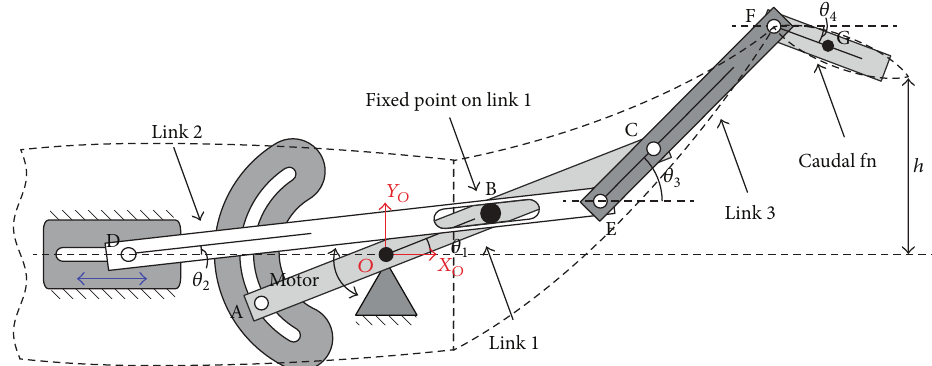
Figure 4: The link mechanism of the tail peduncle.